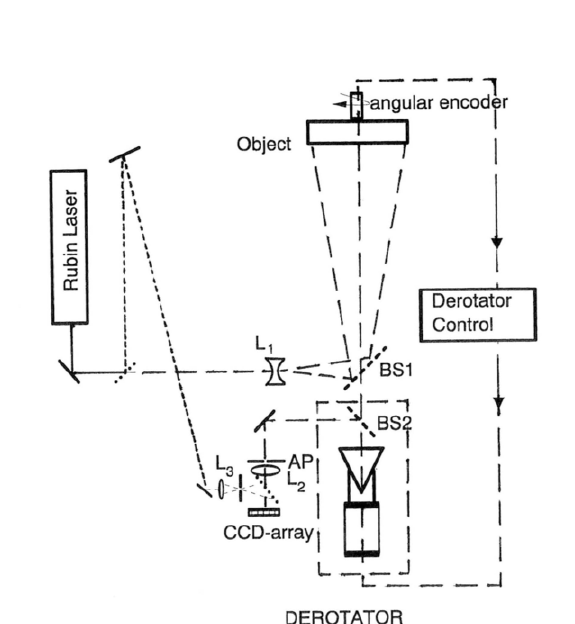
FIGURE 9 Optical setup for double-pulse speckle intelferometry with rotating object.